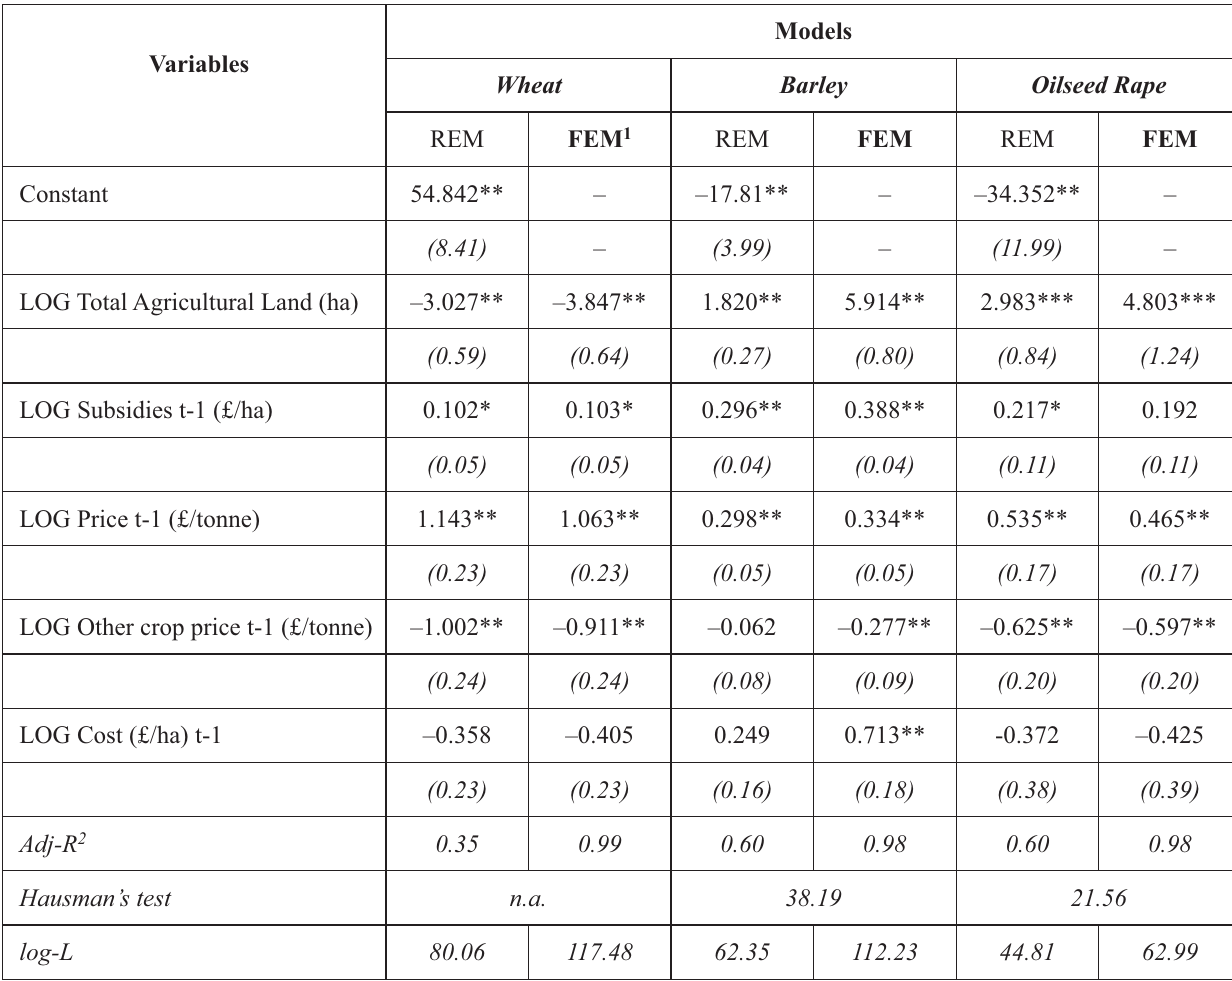
Table 2. Comparison of results of land allocation models including production cost (dependent